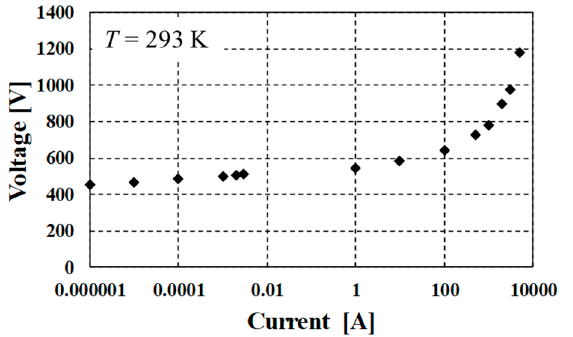
Figure 1. Measured voltage-versus-current (V-I) property of an MOV element. Reprinted with permission from ref. [12]. Copyright 2020